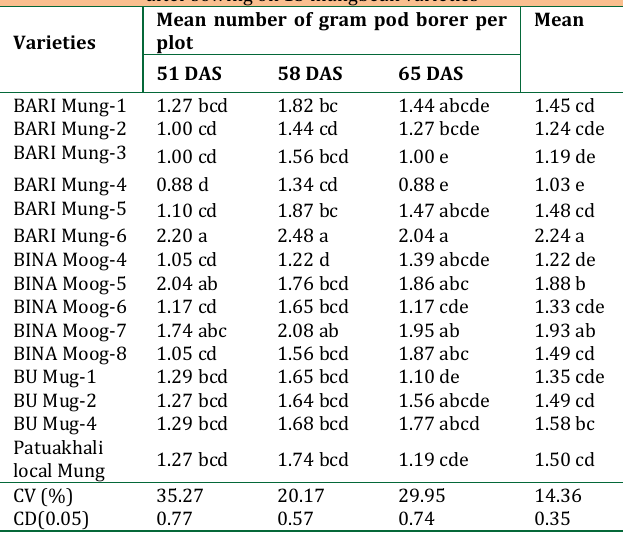
Table 2: Mean number of gram pod borer per plot at different days after sowing on 15 mungbean varieties Mean number of gram pod borer per Varieties plot